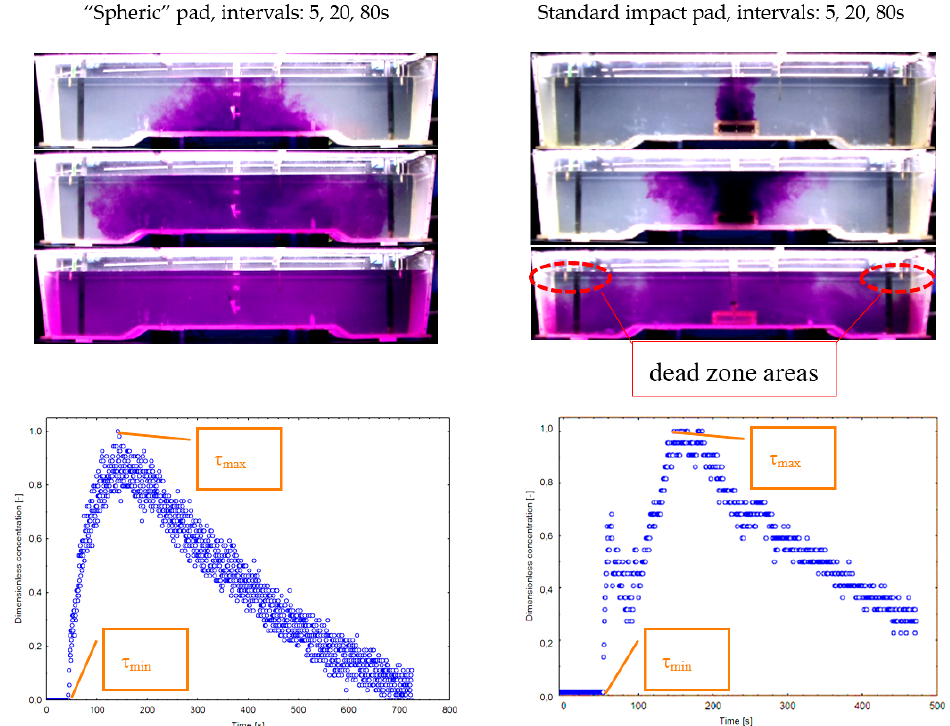
Figure 7. Visual and graphical comparison of flow for “Spheric” impact pad and for standard impact pad at simulated casting speed 1.2 m min − 1 —physical simulation.